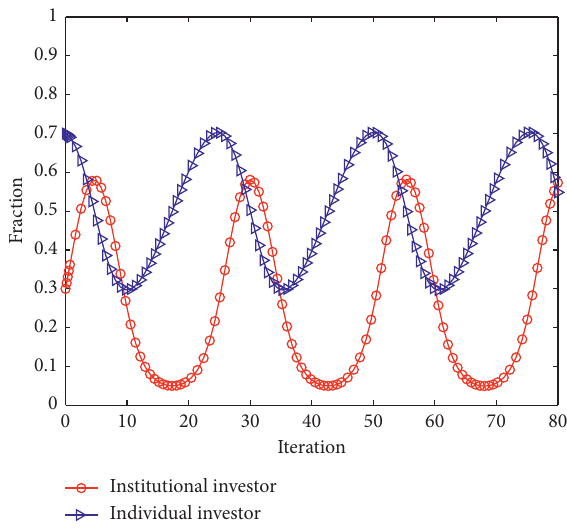
Figure 3: Simulation results for institutional individual investors using parameters R M � 2, C M � − 2, R δ � 0 .